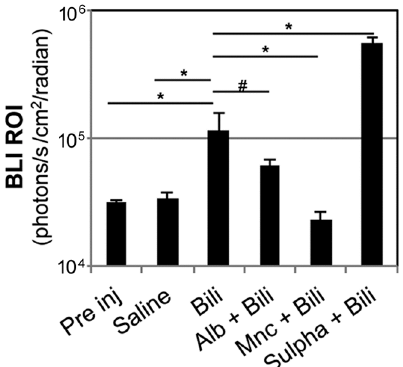
Figure 4. Effect of different pharmacological treatments on brain bioluminescence modulation.